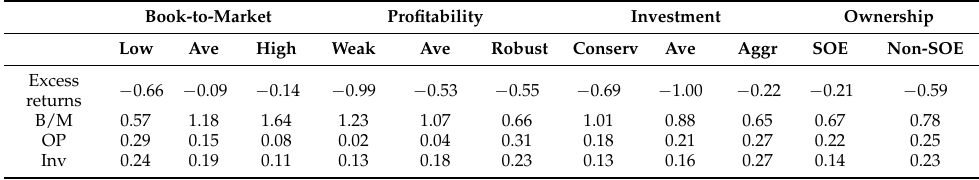
Table 3. Characteristics of value-weighted single-sorted portfolios. The table provides time-series averages of average percentage monthly excess returns, book-to-market (B/M), profitability (OP) and investment (Inv) ratios in July of year t to June of year t + 1 for portfolios formed in December of year t − 1 on a single sort of book-to-market, profitability or investment. Portfolio breakpoints are the 33rd and 67th percentiles. Each of the ratios for a portfolio in a given year is the value-weighted average of the ratios for the firms in the portfolios. Firms in the columns ownership are sorted on (state) ownership structure. Column low (under book-to-market) shows the characteristics of the portfolios of stocks with low book-to-market ratio. Column Ave shows the characteristics of portfolios of stocks with an average book-to-market ratio. Column High shows the characteristics of portfolios of stocks with a high book-to-market ratio. Column weak (under profitability) shows the characteristics of the portfolios of stocks with a low profitability ratio. Column Ave (under Profitability) shows the characteristics of portfolios of stocks with an average profitability ratio. Column Robust shows the characteristics of portfolios of stocks with high profitability ratio. Column Conserv (under Investment) shows the characteristics of portfolios of stocks with a low investment ratio. Column Ave shows the characteristics of portfolios of stocks with average investment ratio. Column Aggr shows characteristics of portfolios of stocks with high investment ratio. The sample is from September 2008 to July 2015. Book-to-Market − 0.66 − 0.09 −